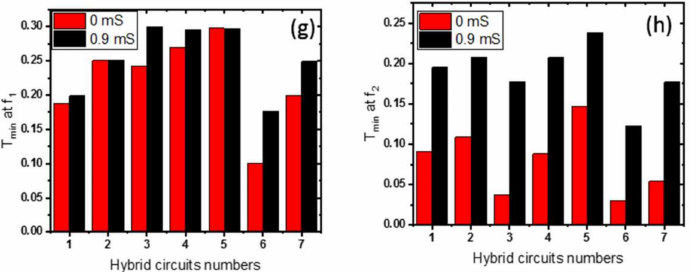
Figure 6. THz transmission of the hybrid photonic integrated circuit when the bright/dark resonators are set to be ( a ) Nb (at T = 4.5 K)/Au and ( b ) Nb (at T = 10 K)/Au at three different graphene conductivities. The same info is given in ( c ) and ( d ) but with Nb and Au replaced in the SRR unit- cells. Insets show one unit-cell, where Nb SRR is shown in black, and Au SRR is shown in yellow. ( e ) THz transmission of the photonic integrated circuit when the bright/dark resonators are both set to be Au. ( f ) FWHM at σ 0 = 0 mS, ( g ) transmission minimum at the first resonance, and ( h ) transmission minimum at the second resonance of the hybrid circuit bright/dark resonators. Here, each device is labeled as 1-Nb (at T = 4.5 K)/Au, 2-Nb (at T = 10 K)/Au, 3-Au/Nb (at T = 4.5 K), 4-Au/Nb (at T = 10 K), 5-Au/Au, 6-Nb (at T = 4.5 K)/Nb (at T = 4.5 K), 7-Nb (at T = 10 K)/Nb (at T = 10 K) at σ 0 = 0 mS and at σ 0 = 0.9